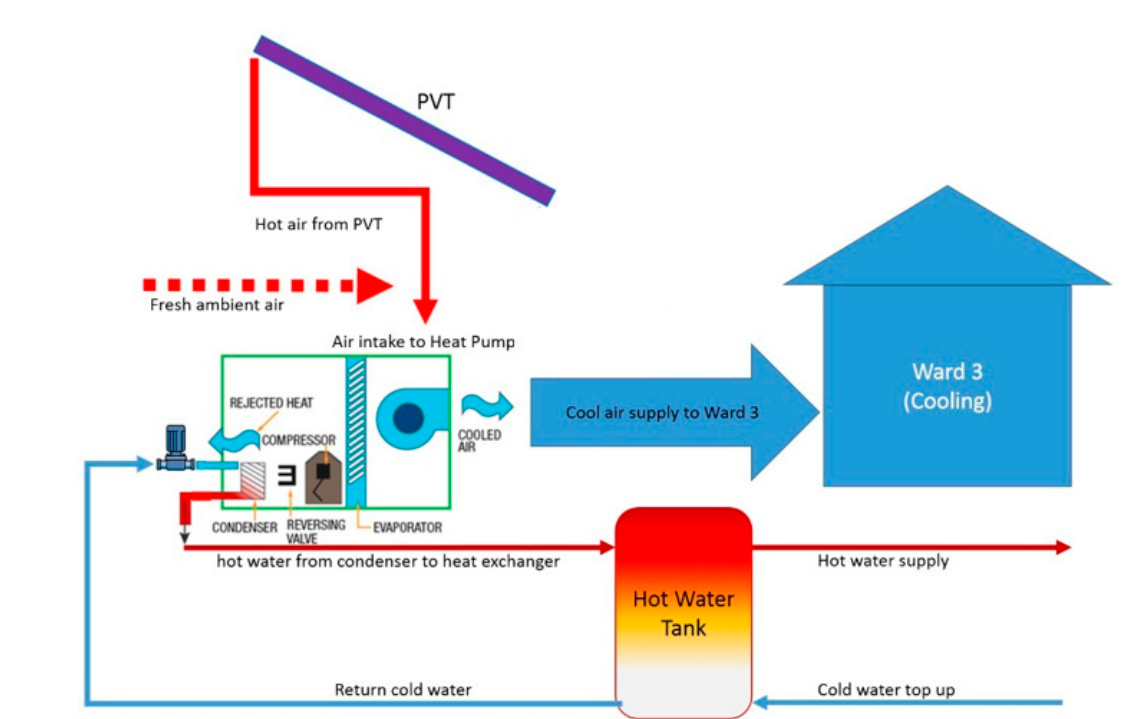
Figure 5. Proposed concept of hybrid PV/T and heat pump system for naturally ventilation ward.